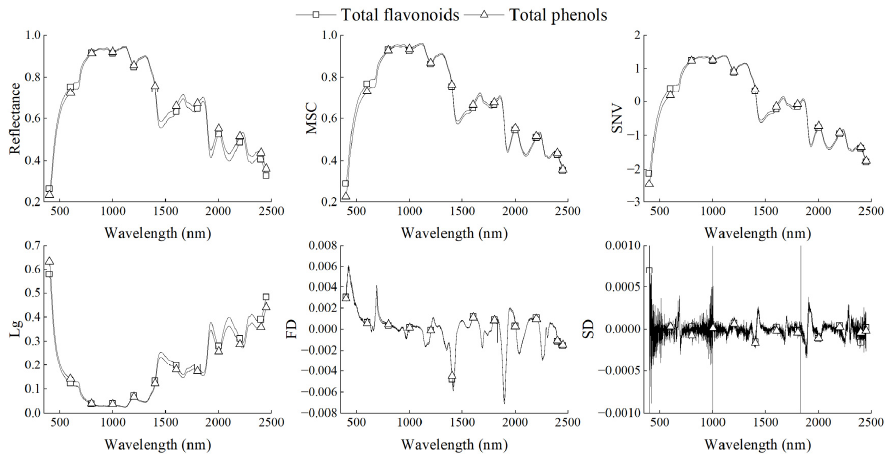
Figure 1. Spectral re fl ectance of di ff erent preprocessing.